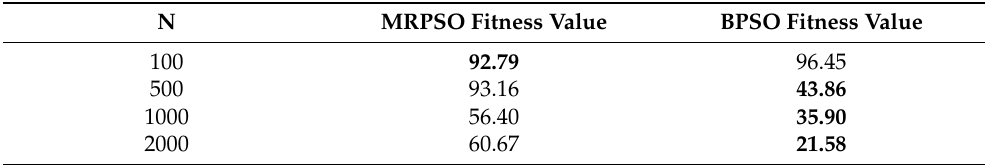
Table 8. Mean of the particle best-fit values in MRPSO and BPSO on f 3 . The bold numbers refers to the better results.